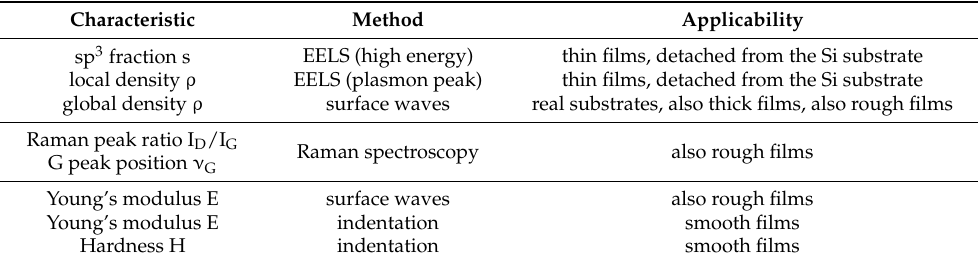
Table 3. Advantageous characterization methods for hydrogen-free carbon